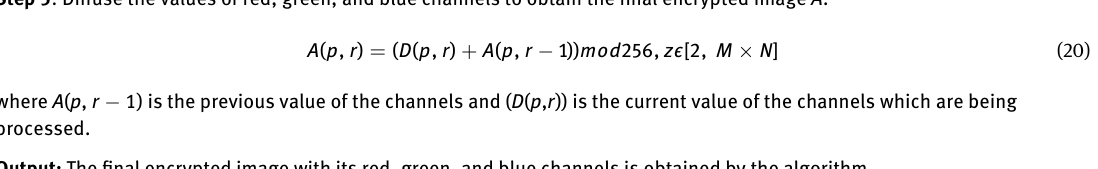
Figure 2A–D show a final encrypted color image with the red, green, and blue channels, respectively.